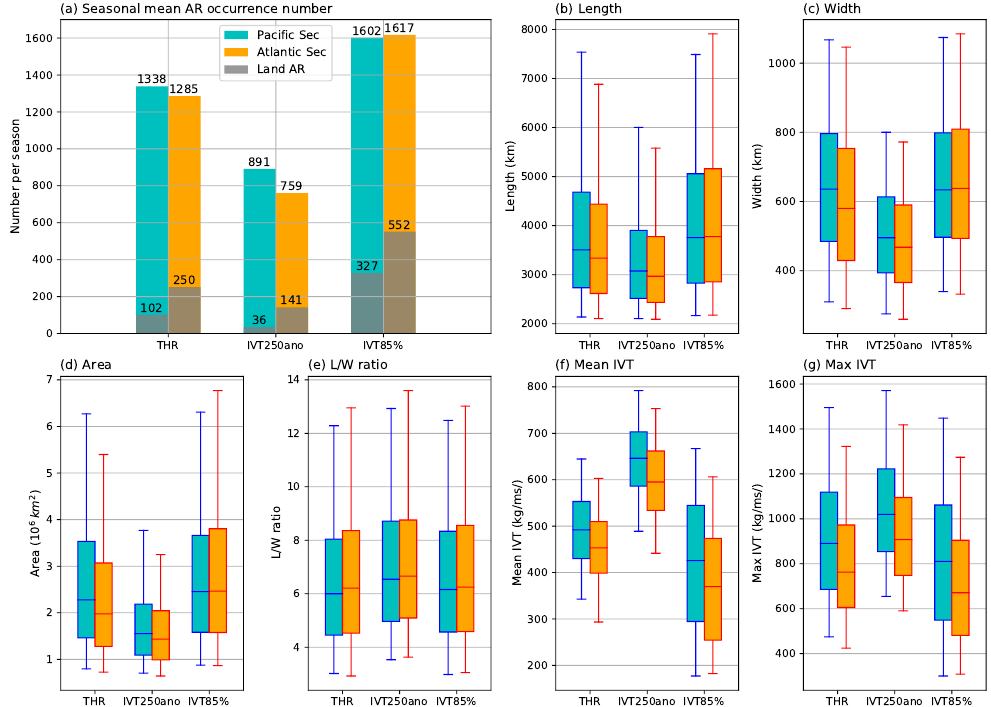
Figure 1. ( a ) Average seasonal AR occurrences during the November–April season of November 2004 to April 2010 period reported by the three detection methods. The number for the North Pacific (Atlantic) sector is shown in cyan (orange). In each sector, the number of ARs that have their centroids located over land area are shown as grey shading. ( b – g ) are the distributions of length (km), width (km), area (10 6 km 2 ), length/width ratio (km/km), average IVTwithin AR (kg/m/s), and the maximum IVT (kg/m/s) within